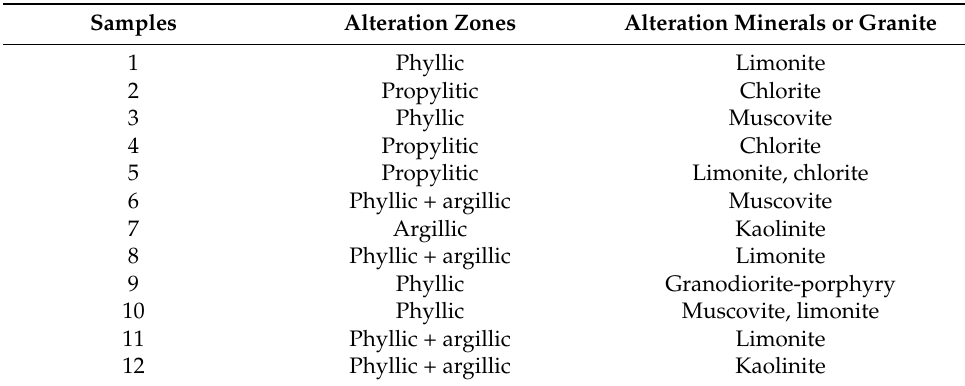
Figure 4. The OLI false color composite image (band 7, 5, 2 in RGB) of the Duolong area, Tibetan Plateau showing the field sample locations. Table 3. The alteration zones and alteration minerals of 12 samples.